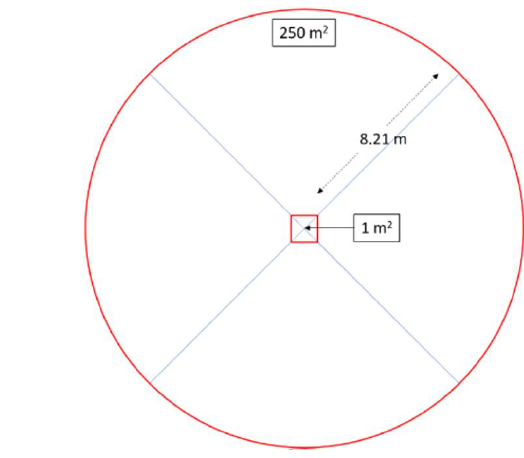
8 of 17 Figure 2. Workflow of the process of predicting open wetlands from Sentinel-2 imagery using